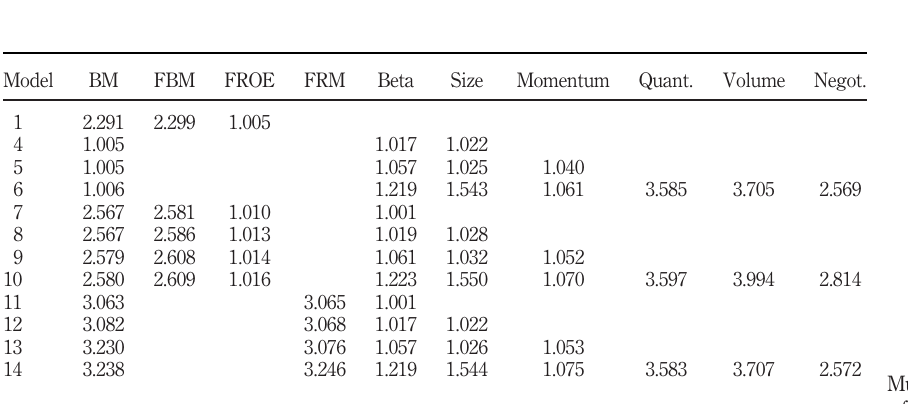
Table V. Multicollinearity test